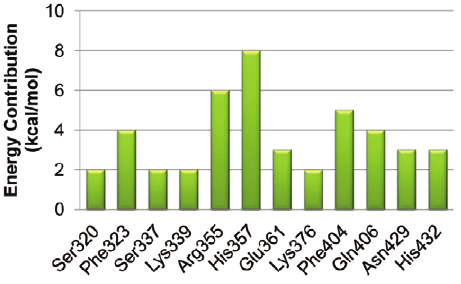
Figure 2. Energy contributions (kcal/mol) for each residue to the binding free energies of the PB2-m7GTP complex. Only the residues that have positive contributions to the binding free energies are listed in this figure. Among these residues, His357 has the most contributions owe to having both hydrogen bonding and p - p stacking interactions with the cap analog